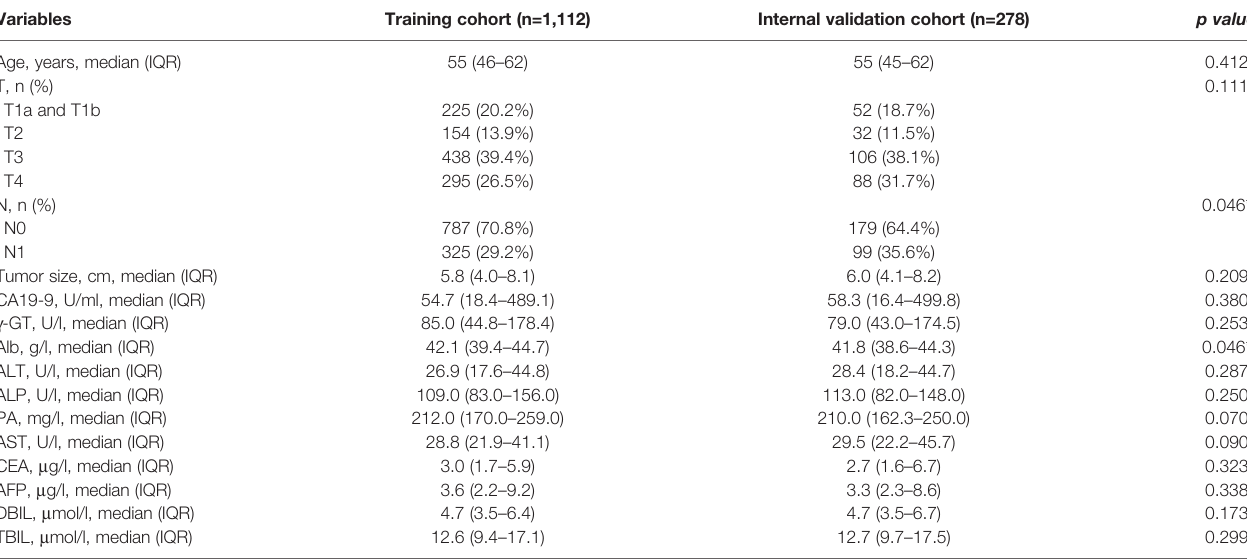
TABLE 3 | Variable characteristic statistics of the training cohort and internal validation cohort. Variables Training cohort (n=1,112)